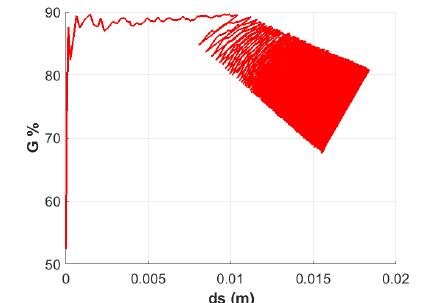
Fig. 4. Evolution of G vs slab settlement ds.